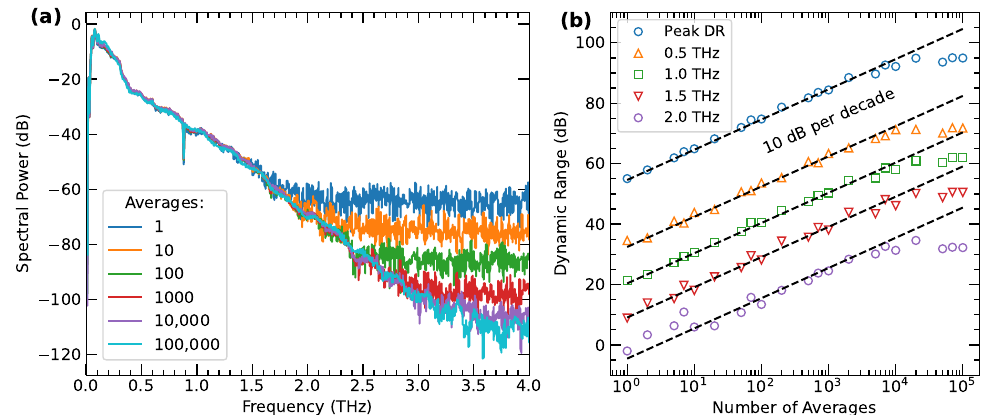
Figure 2. ( a ) Spectral power and dynamic range using 1 to 100,000 averages. ( b ) The dynamic range at the peak and at four selected frequencies as a function of number of averages, showing the 10dB per decade slope (dashed lines) and saturation above 20,000 averages.